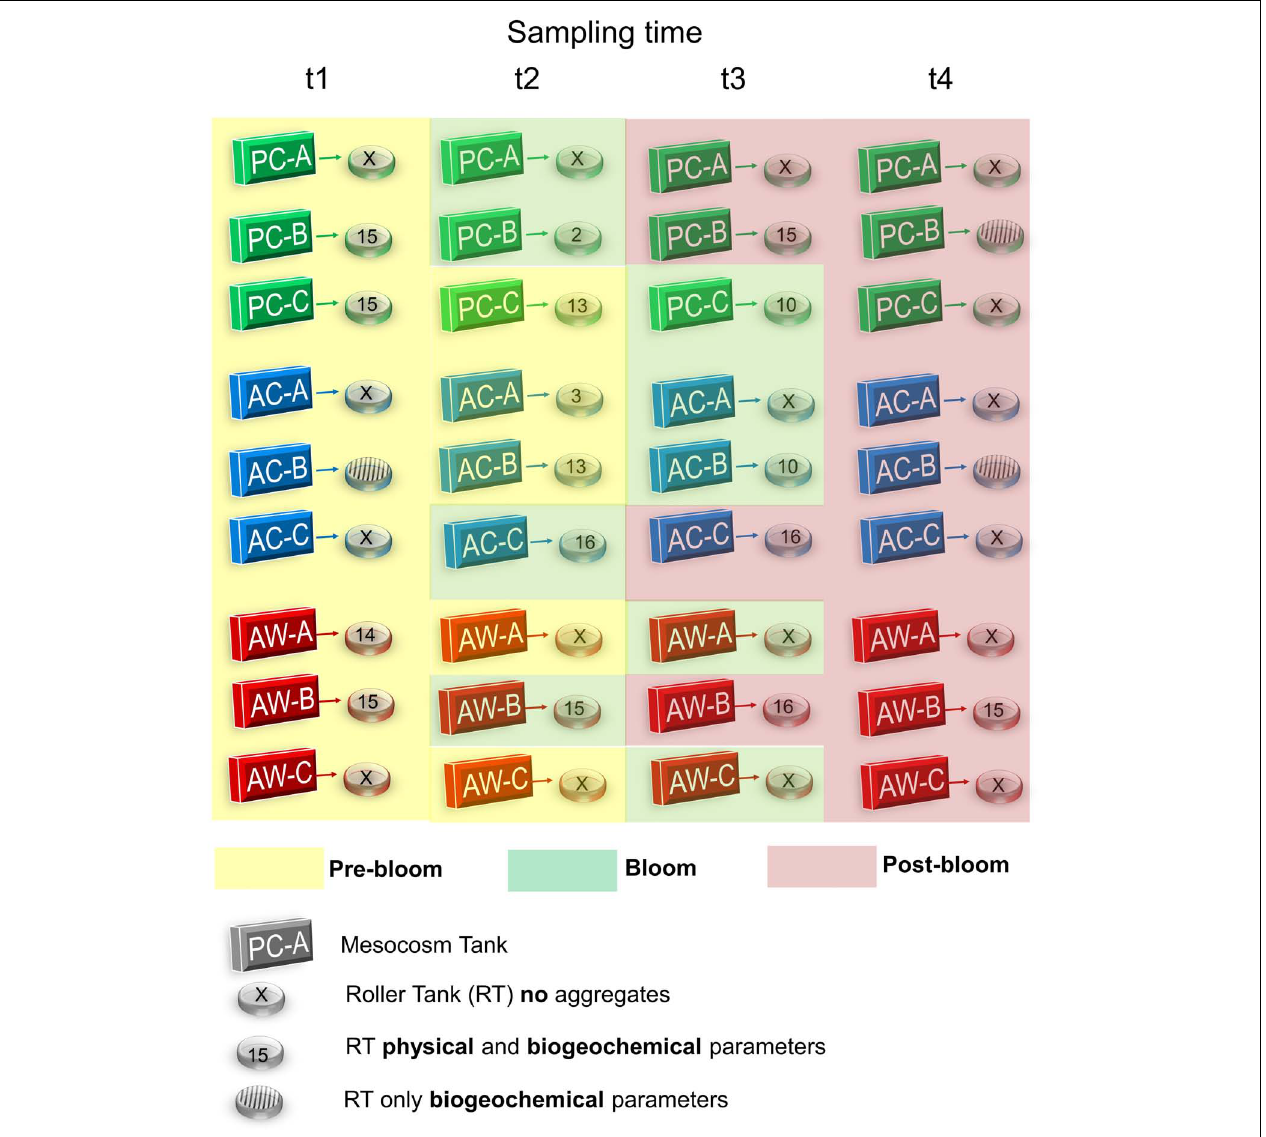
FIGURE 1 | Experimental setup for the mesocosm (cubes) and aggregation (cylinders) experiments. There were three treatments: present CO 2 -cooler (PC, 380 ppm and 16 ◦ C) in green; acidified-cooler (AC, 750 ppm and 16 ◦ C) in blue; and acidified-warmer (AW, 750 ppm and 20 ◦ C) in red. Water was removed from each mesocosm four times (t1 to t4) during Pre-bloom (in yellow), Bloom (in green) and Post-bloom (in red) to start aggregation experiments. After 48 h, roller tanks that formed aggregates were video recorded. Not all roller tanks formed aggregates; the number inside the roller tanks represent the number of aggregates analyzed in the captured video, and roller tanks that did not form aggregates are marked with an